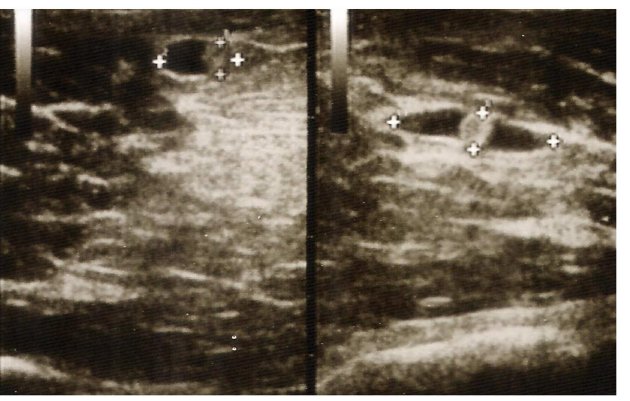
Fig 1. Viable Taenia solium cysticerci detected by ultrasonography of a live pig using a 5.0–10.0 MHz linear transducer. The cystic structures have clearly delineatedborders, clear vesicularfluid, and a central opacity corresponding to the